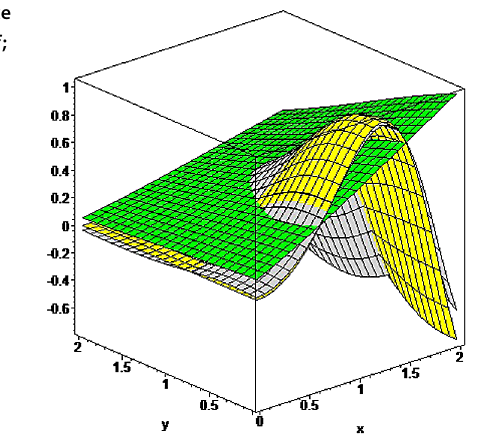
Figure 7 The comparison of rate of convergence of K ( α 1, α 2, β 1, β 2) n 1, n 2, p 1, p ( f ; q 1 , q 2 , x , y ) and T ( α 1, α 2, β 1, β 2) n 1, n 2, p 1, p 2 q 1 , q 2 , x , y ) to f ( x , y